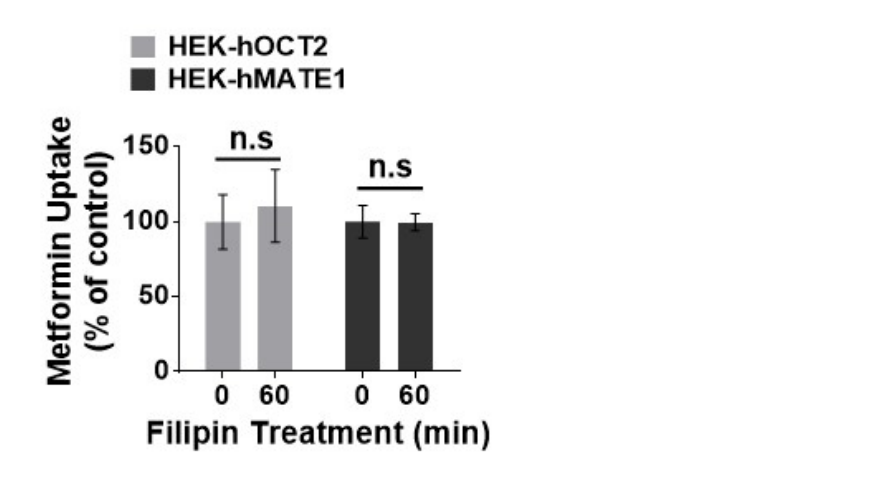
Figure 5. Effect of filipin on the function of hOCT2 and hMATE1. Cellular uptake of metformin in HEK-hOCT2 and HEK-hMATE1 cells after being exposed to filipin at indicated times. Data are presented as mean ± S.D.; n.s., no significance.